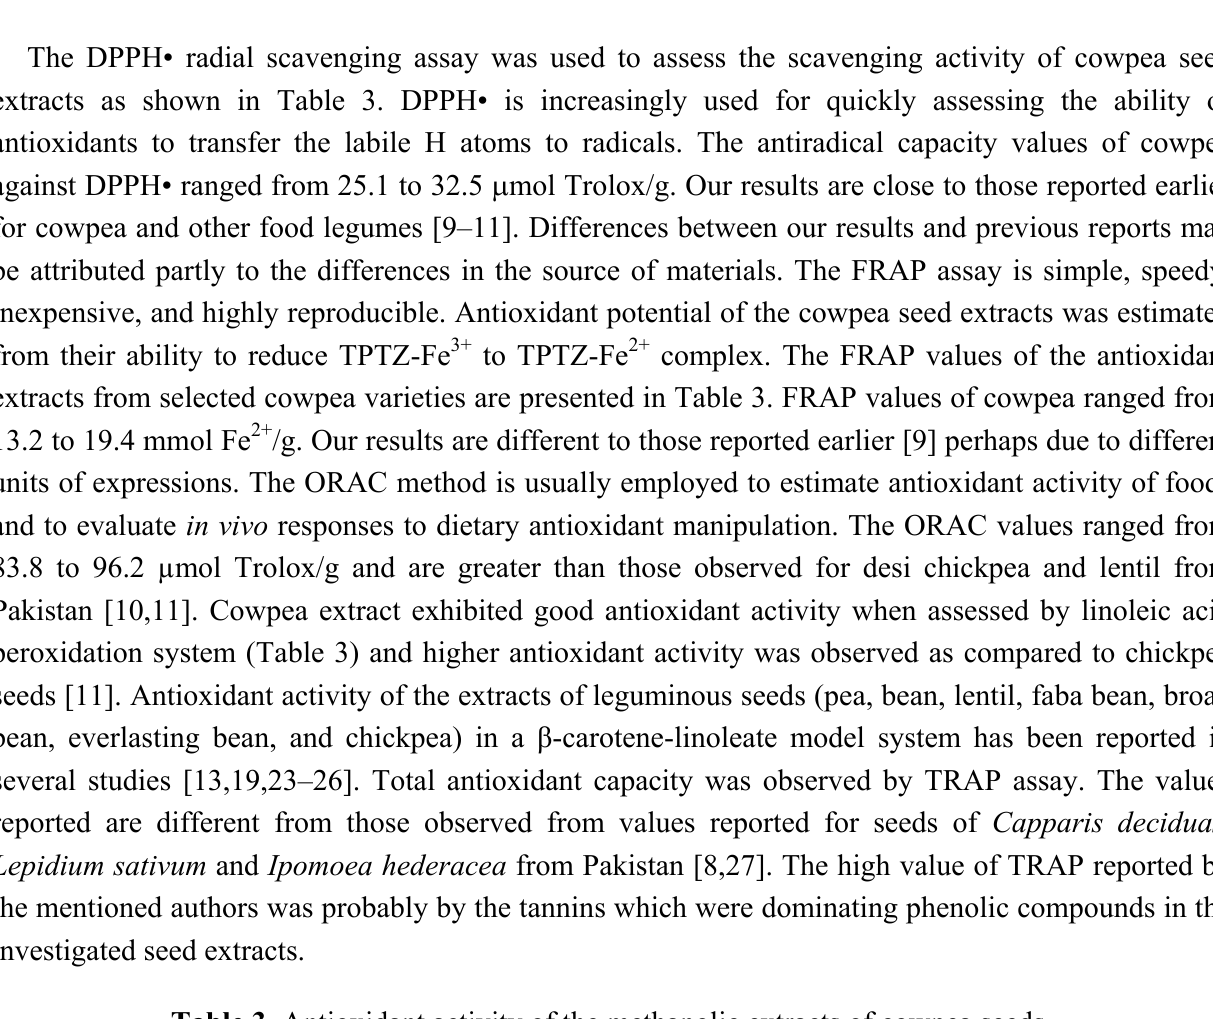
Table 3. Antioxidant activity of the methanolic extracts of cowpea seeds. Assay